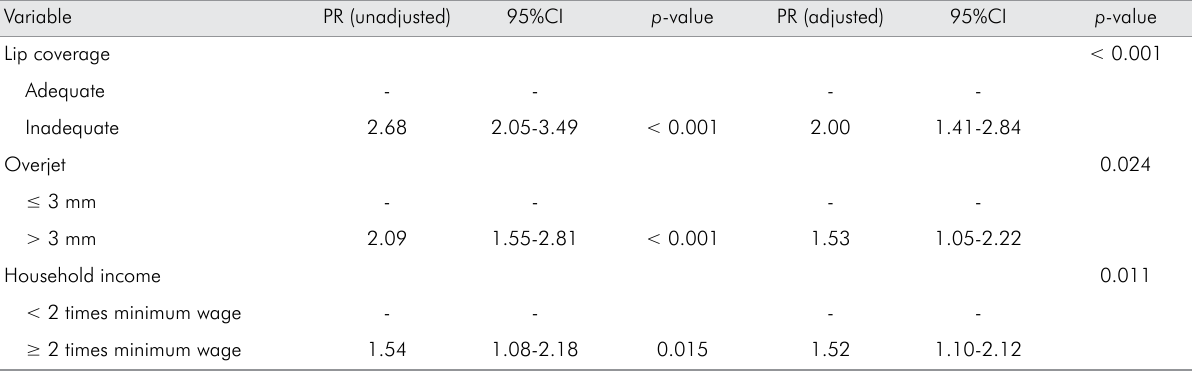
Table 3. Prevalence ratios and confidence intervals for associations between TDI and independent